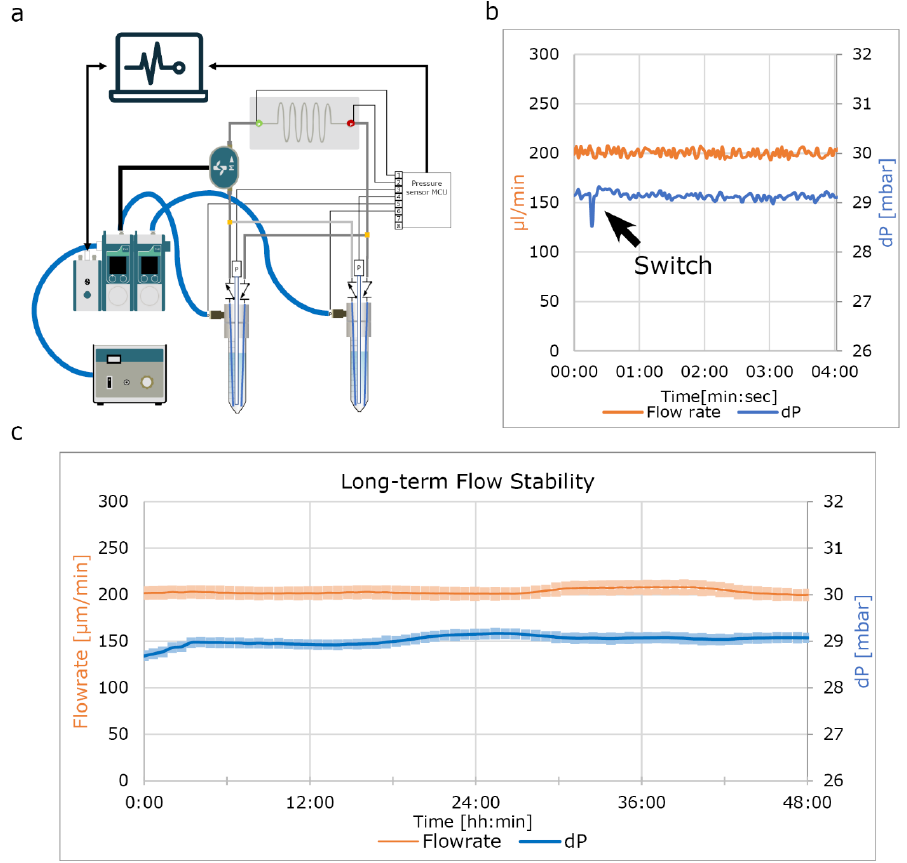
Figure 7. Long-term flow rate stability. ( a ) Schematic of the used fluidic circuit shows a single sample. For this experiment ddH 2 0 was used to demonstrate the functionality of the software in maintaining constant flow rate without the effect of sensor fouling. ( b ) Flow rate and pressure difference for 4 min during a flow reversal shows little variation. ( c ) Two day perfusion using ddH 2 O shows minimal variation. Error band shows the interquartile range of that time